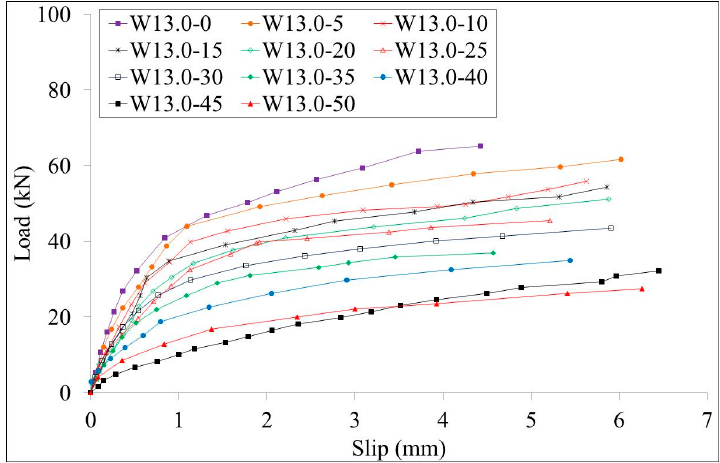
Figure 9. Load-slip curves of the W13.0 series specimens.